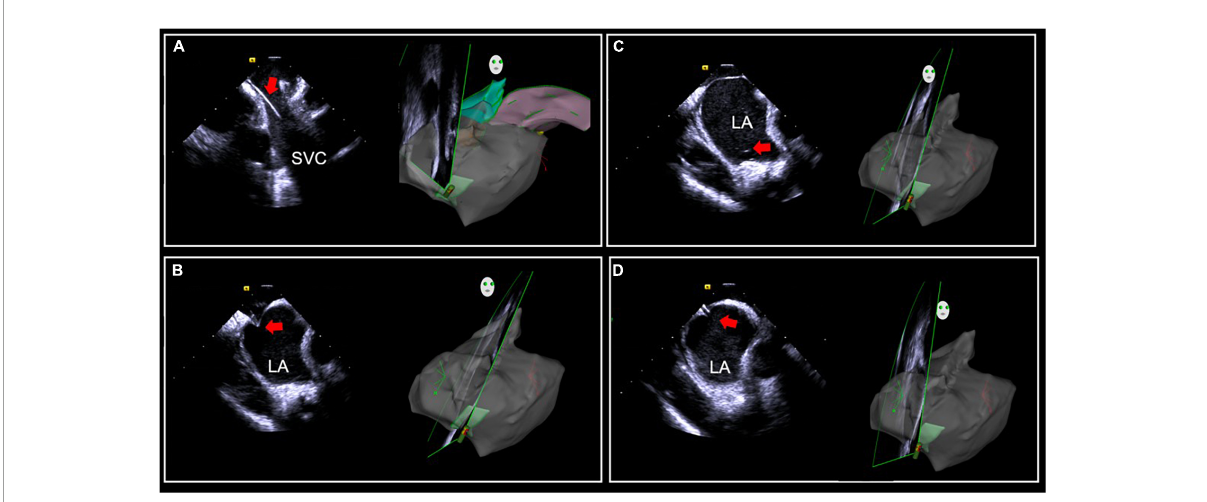
FIGURE1 Intracardiac (ICE)-guided zero X-ray transseptal puncture. (A) Guidewire and sheath seen in SVC. (B) “Tenting sign” in the fossa ovalis by puncture needle sheath. (C) Saline injection microbubbles into the left atrium after the needle is inserted. (D) Needle tip into the left atrium. SVC, superior vena cava; LA, left atrium.